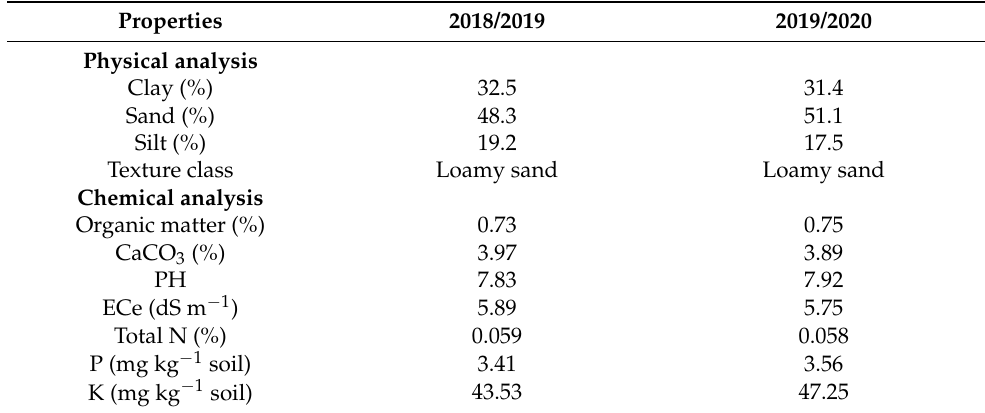
Table 1. Physical and chemical properties of the experimental soil in two seasons